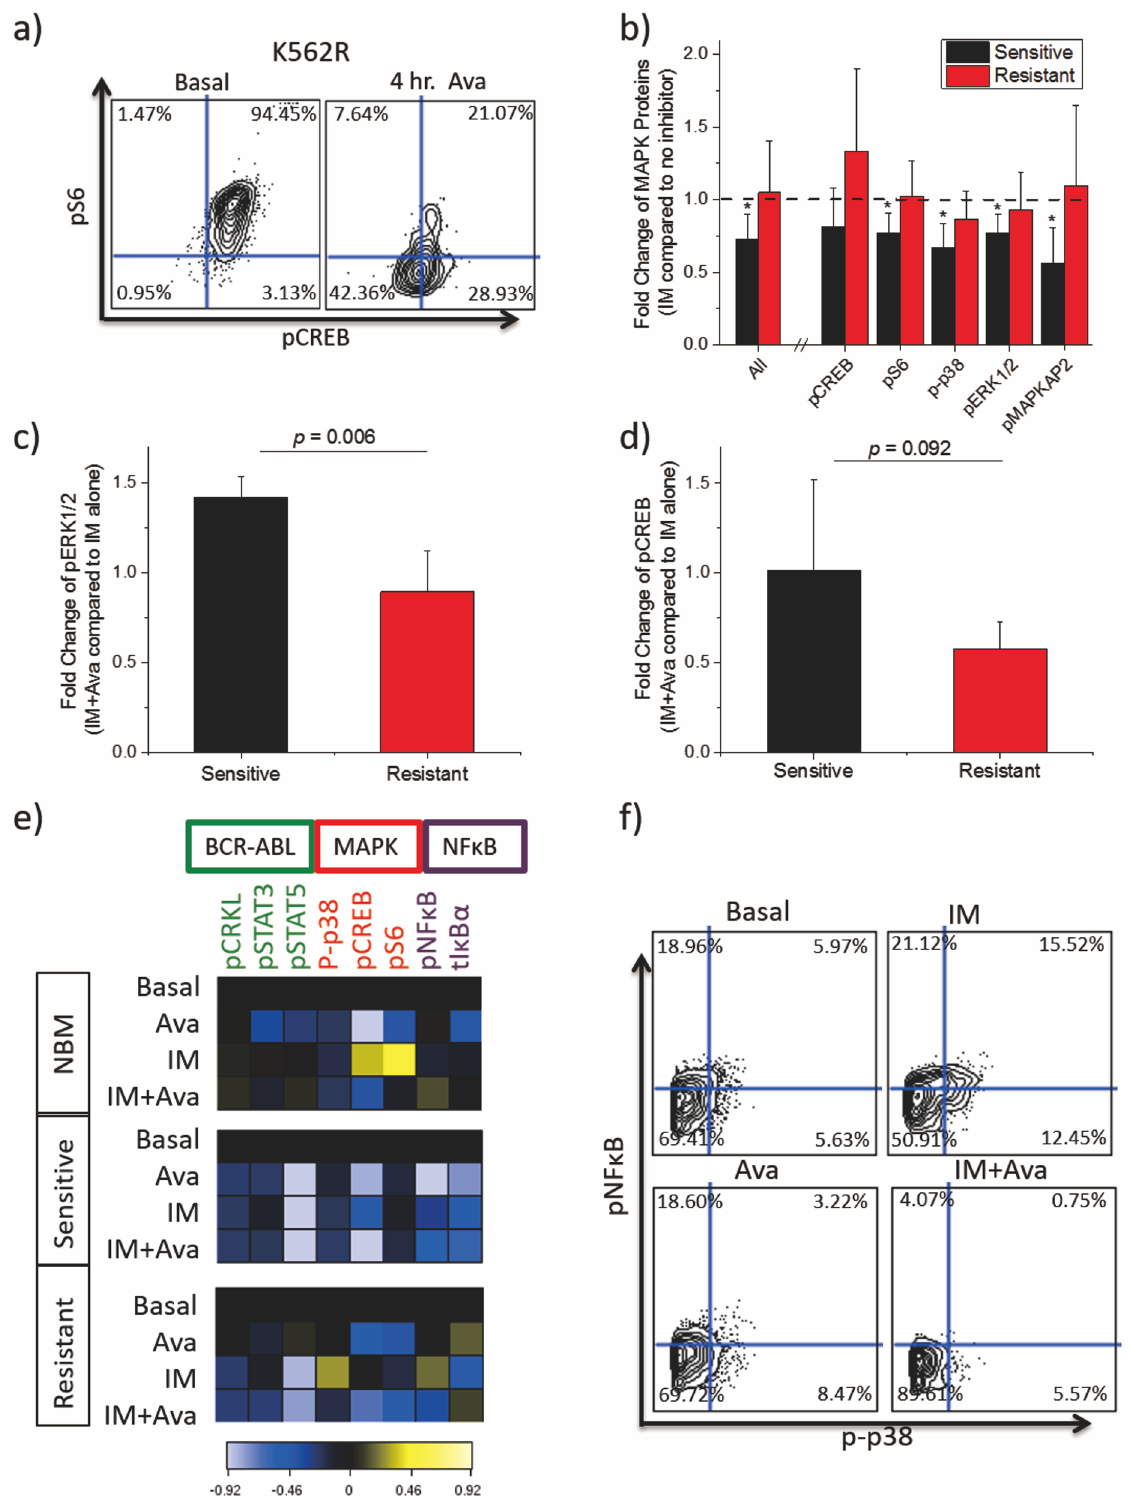
Fig 4. Avasimibe downregulates the MAPK pathway. (a) Contour biaxialsof pS6 (y-axis) and pCREB (x-axis) gated on pCRKL + cells collectedby CyTOF in K562R cells. Cells were treated for 0 or 4 hours with10 μ Mavasimibe.(b) Effect of 30 minute 5 μ M imatinib treatment on sensitiveand resistant patients normalized to the basal conditionon the pooledMAPK pathway proteins